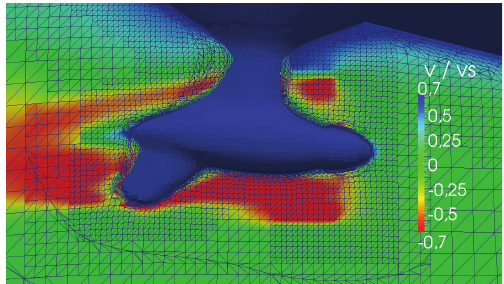
Figure 24: Normalised velocities in a longitudinal cut through the pod